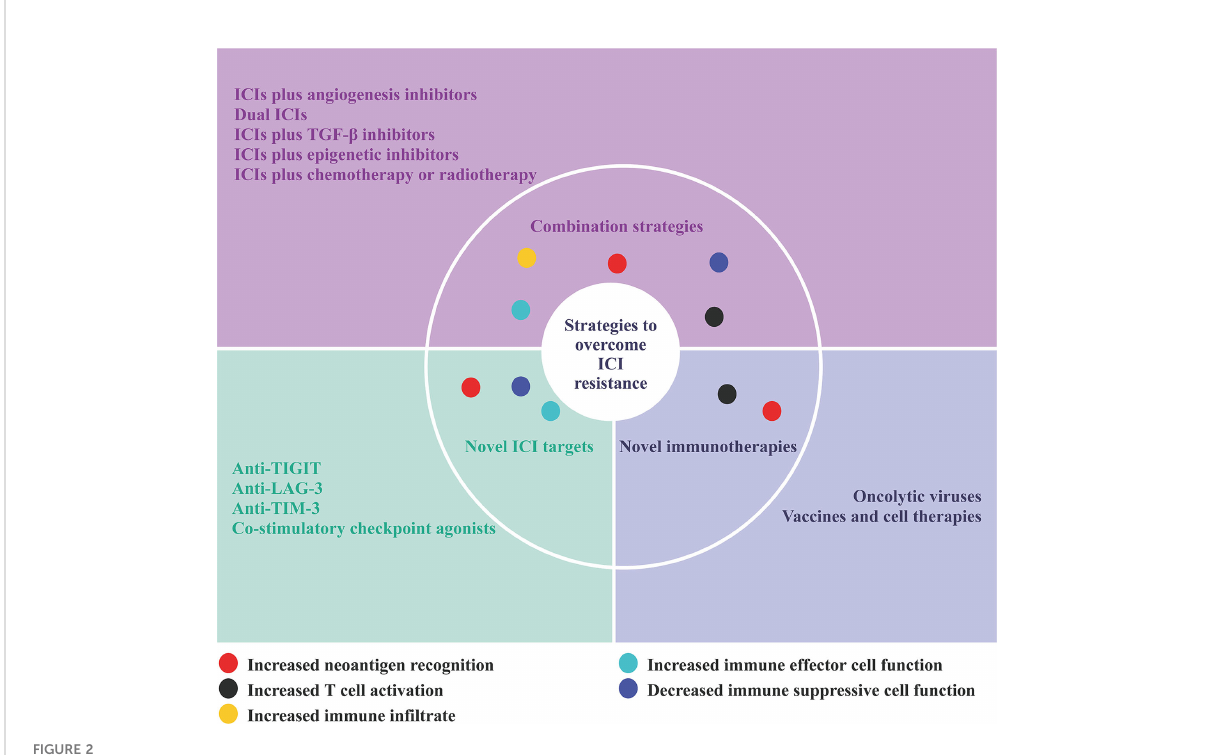
FIGURE 2 Strategies to overcome ICI